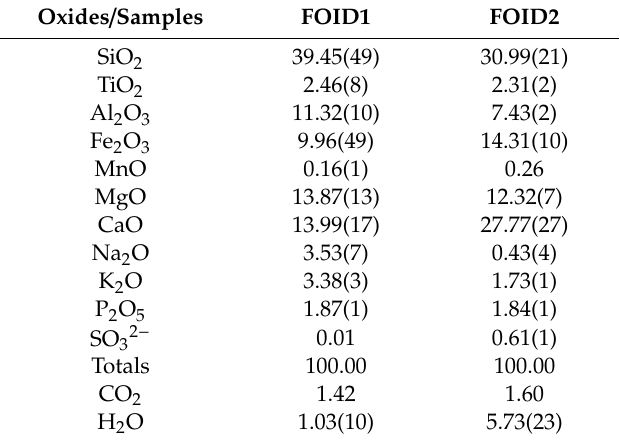
Table 1. Chemical composition of the bulk rocks used as starting materials from XRF